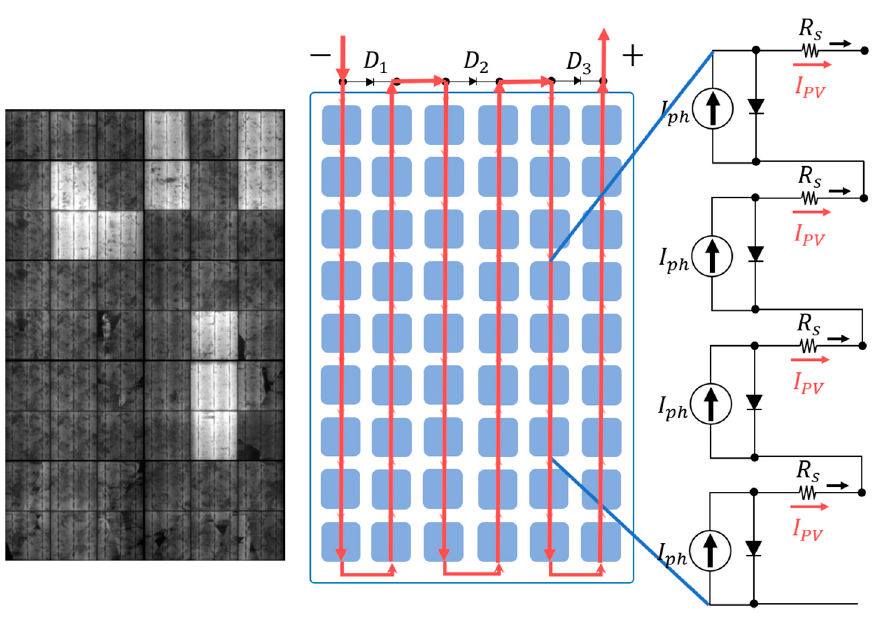
Figure 7. Sub-circuit diagram of 190 A before recovery.